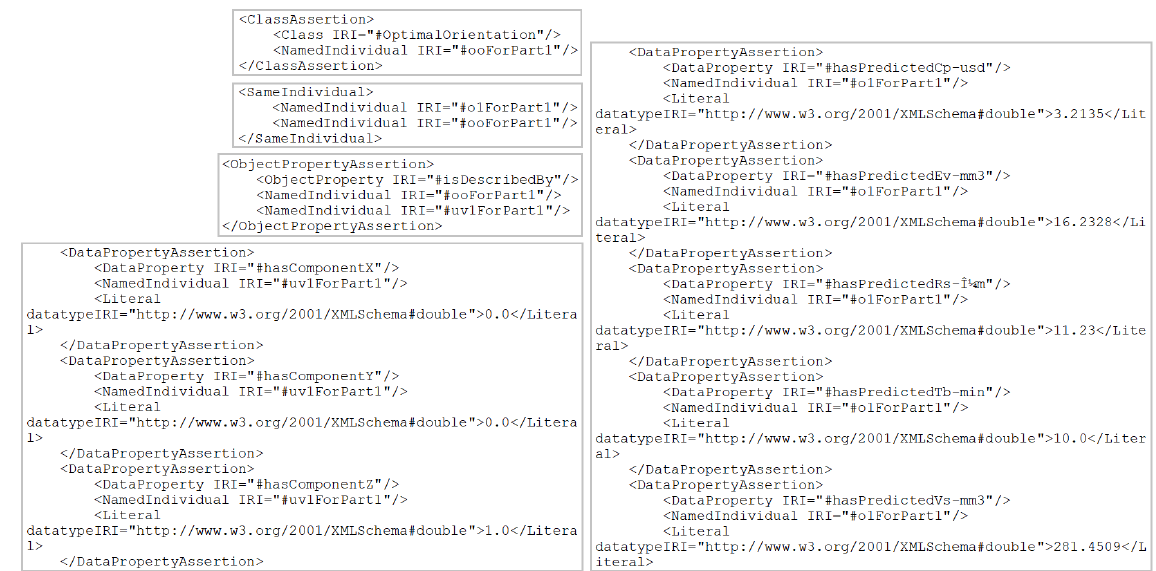
Figure 14. Encoding of the generated optimal orientation for Part